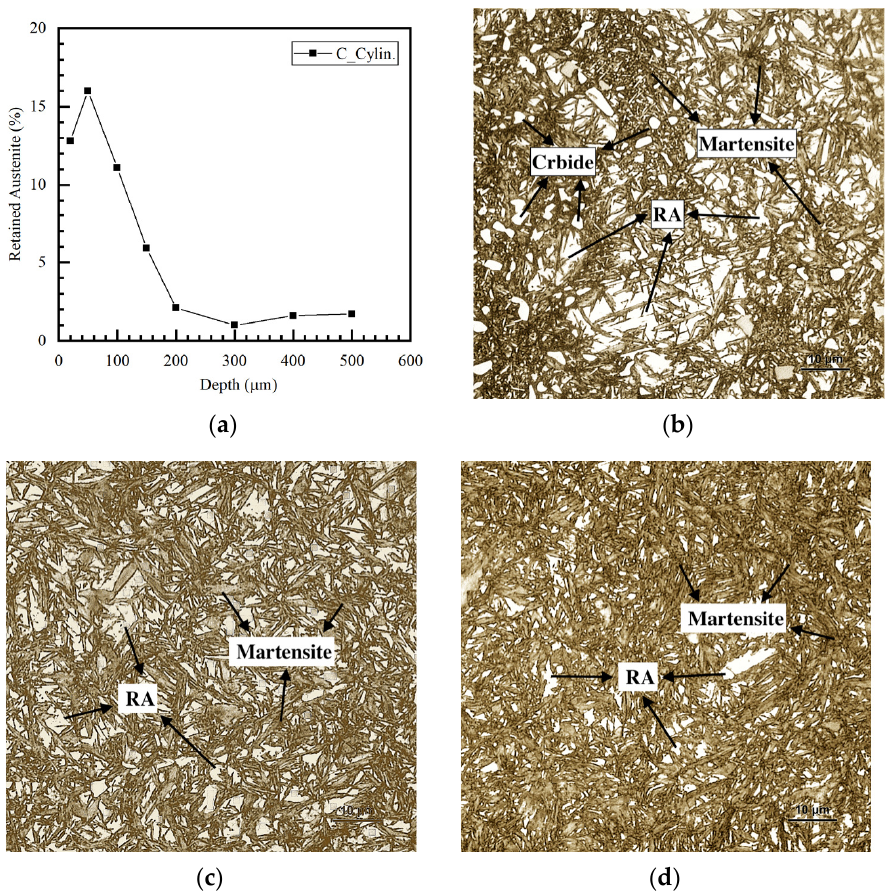
Figure 3. ( a ) Distribution of retained austenite (RA) and microstructures at different depths in the solid specimen: ( b ) on the surface of the solid specimen, ( c ) at the depth of 200 µm, and ( d ) at the depth of 800 µm.